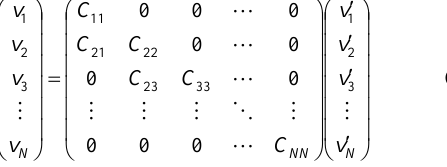
 Triangulate matched features for each stereo pair to obtain 3D